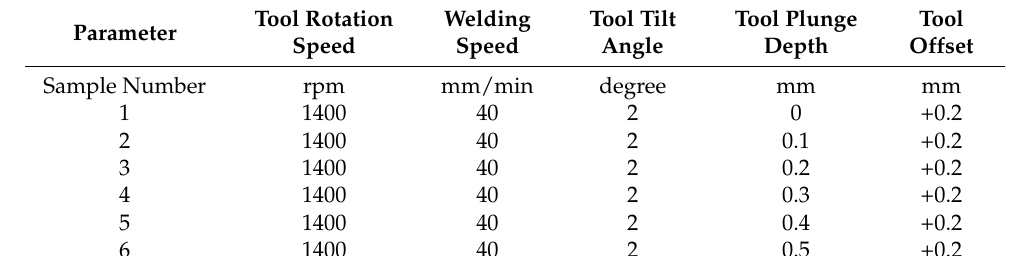
Table 3. Welding process parameters.